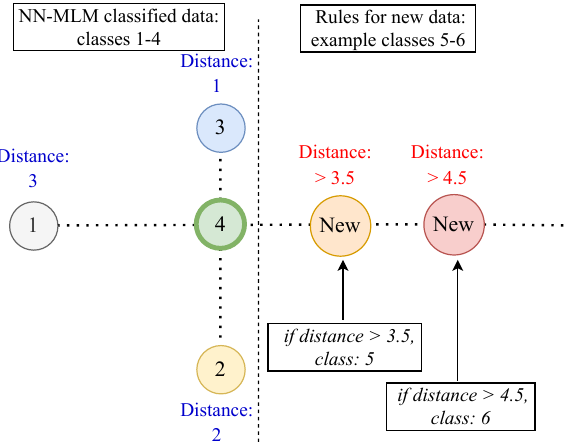
Figure 1: Classification rules for the new classes. Classes 1- 4 were classified using the NN-MLM. The distances from the biggest known class four (4) are written in blue. The image show the first updating rules. The longest distance of the class four (4) is 3, all distances longer than 3.5 were re-classified to a bigger class. The biggest class was updated and again, the longest dis- tance was set to 4.5 (5 - 0.5), and the data was re-checked. Each time a new class appeared, all of the biggest class datapoints were re-checked with this halfway limit as many times as we had new classes.